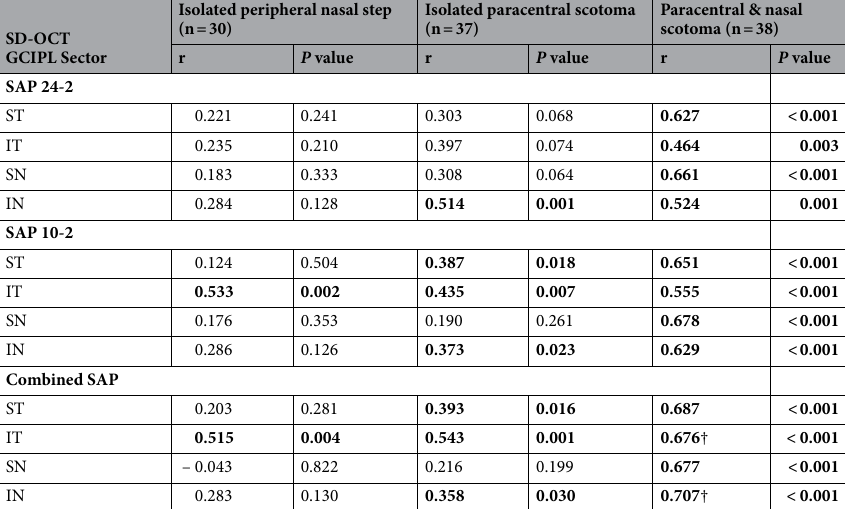
Table 4. Topographic structure–function relationship between regional visual field sensitivity measured with standard automated perimetry 24-2 or standard automated perimetry 10-2 or combined SAP and the corresponding ganglion cell-inner plexiform layer(GCIPL) thickness in glaucoma patients. Statistically significant values ( P < 0.05) are shown in bold. GCIPL, Ganglion cell-inner plexiform layer; SAP, standard automated perimetry; SD-OCT, spectral domain optical coherence tomography. r = Pearson’s correlation coefficient. *Statistically significant difference with P < 0.05 between SAP 24-2 and SAP 10-2. † Statistically significant difference with P < 0.05 between SAP 24-2 and combined SAP. ‡ Statistically significant difference with P < 0.05 between SAP 10-2 and combined